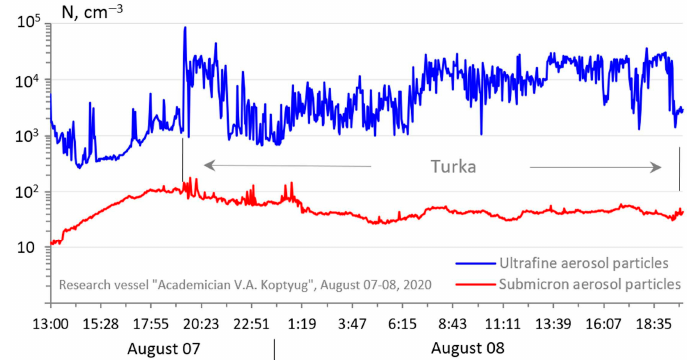
Figure 12. Temporal variation of the concentration of ultrafine and submicron aerosol in the near- water layer of Lake Baikal in the period 7–8 August 2020 (Turka settlement).